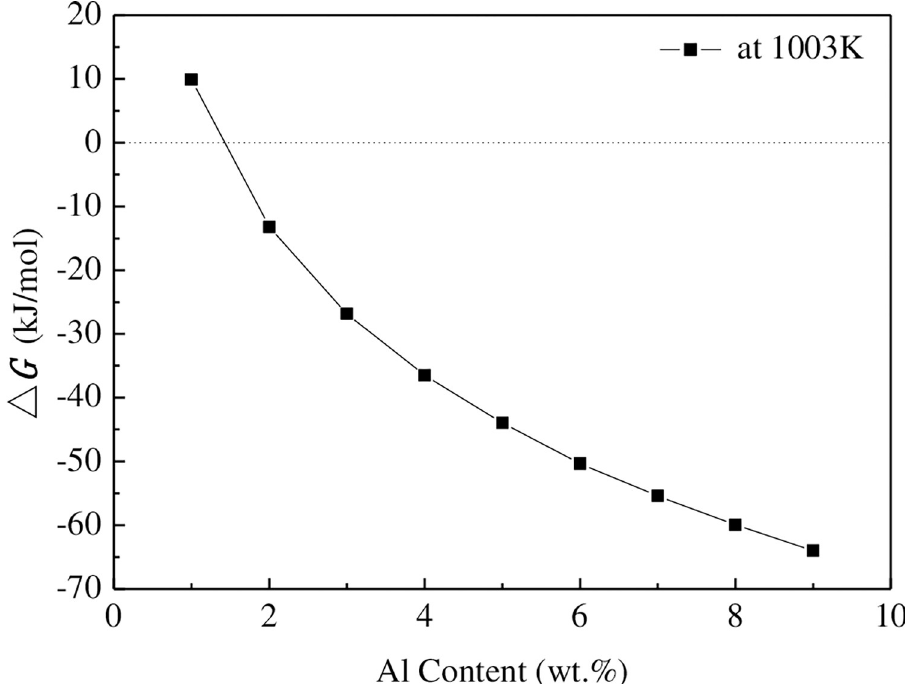
Fig 9. Variation in the Gibbs free energy of Al 4 C 3 with Al content.